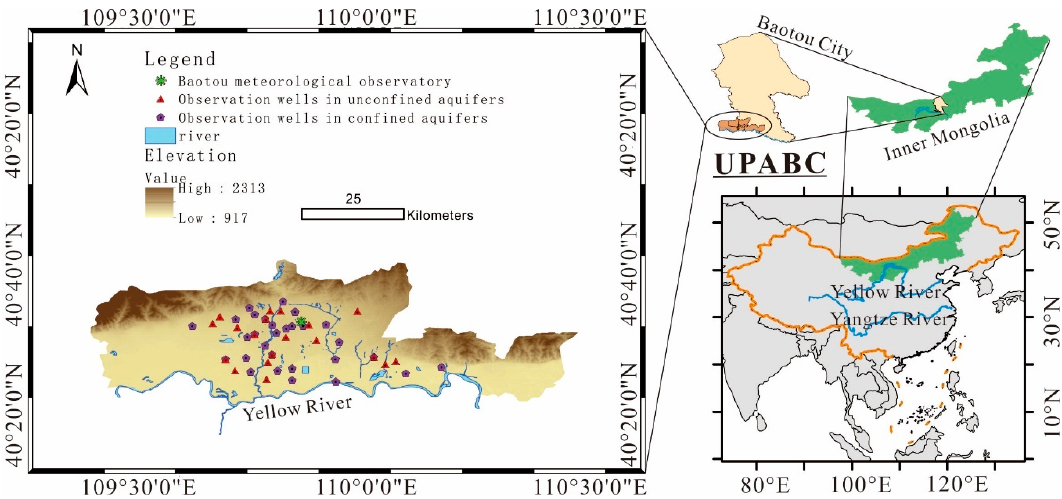
Figure 1. The locations of the Urban Planning Area of Baotou City (UPABC), the river system, a meteorological observatory, and observation wells.